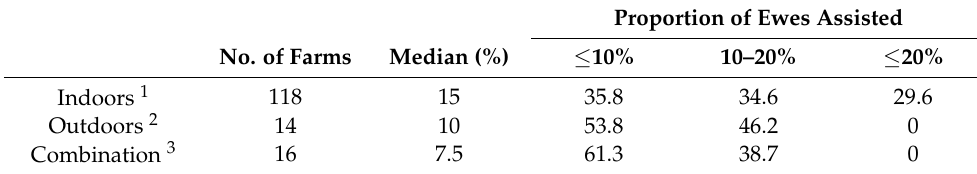
Table 5. Proportion of ewes assisted at lambing on lowland